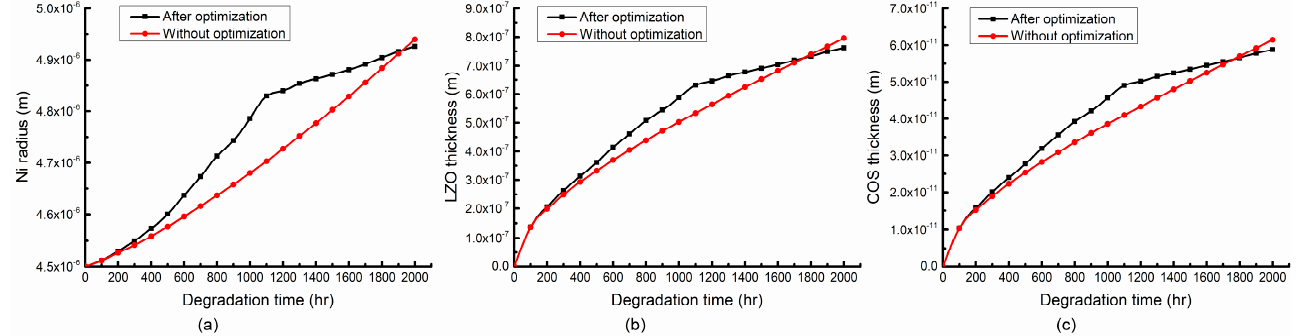
Figure 10. Variation trends of structural parameters ( a ) Ni radius, ( b ) LZO thickness and ( c ) COS thickness over time during optimization.